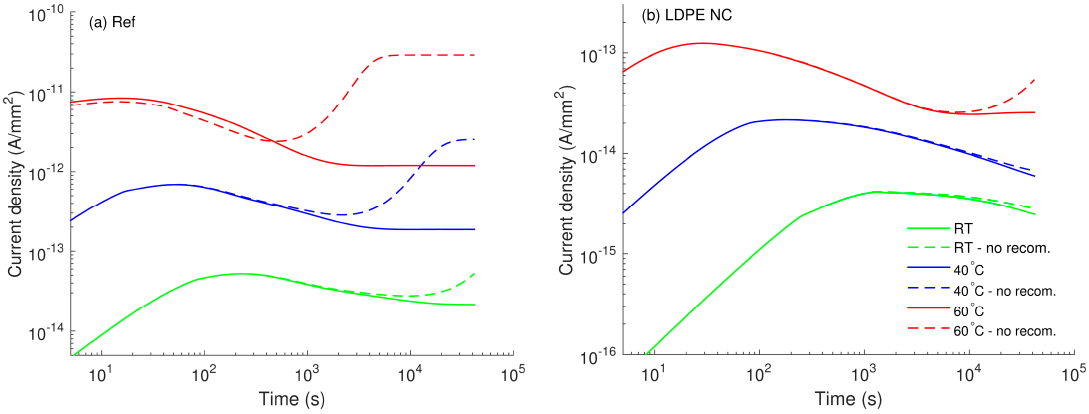
Figure 9. Simulated conduction currents obtained from models with (solid curves) and without (dashed curves) charge recombination.